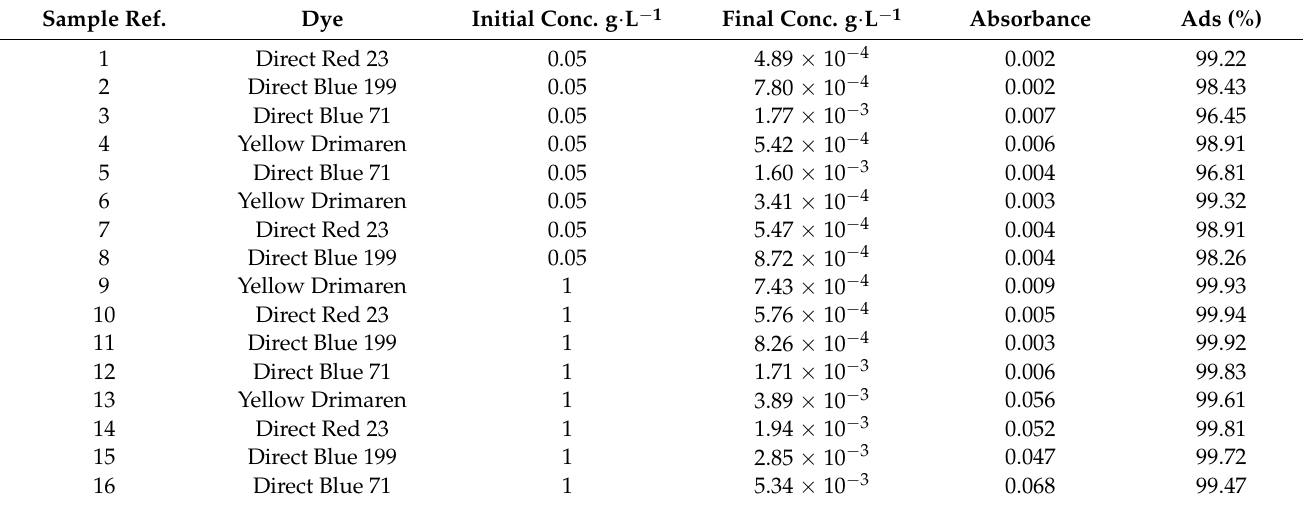
related to the dye/clay concentration. Table 1. Differences in concentrations after HC adsorption.